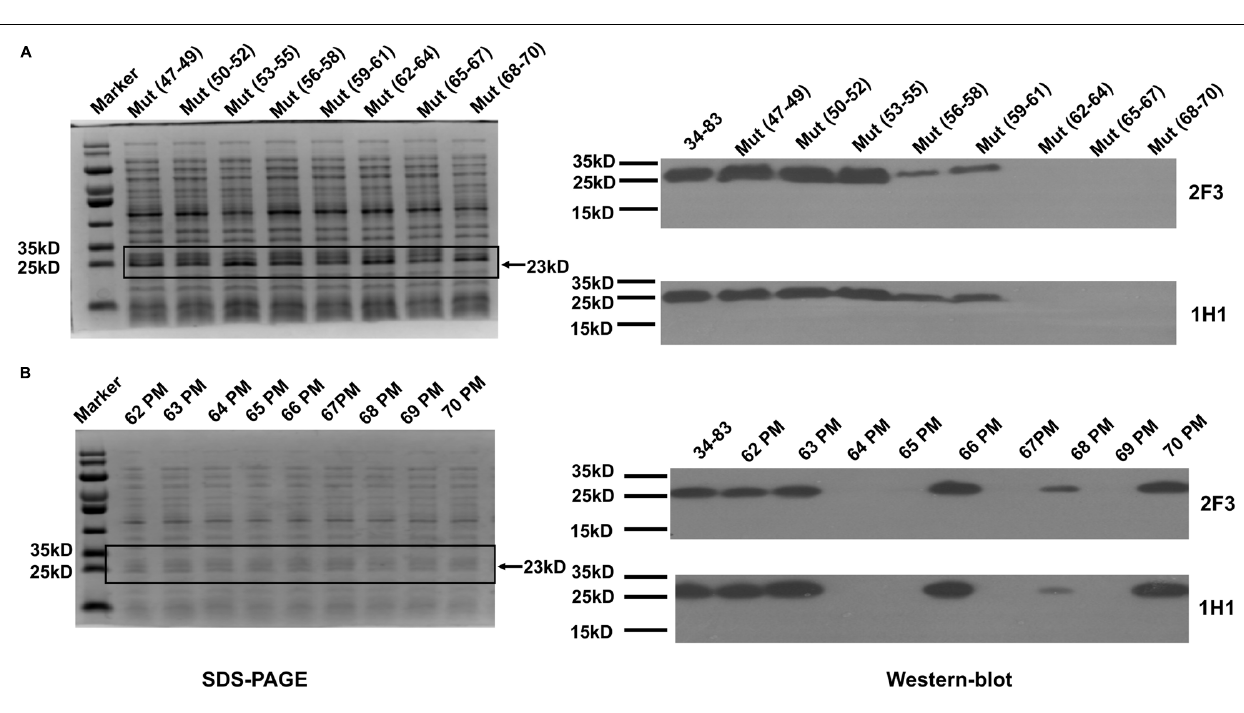
FIGURE 5 | Identification of critical amino acid residues in YycG ex domain epitope. Specific recognition by YycG ex mAbs of TF 34 − 83 harboring alanine substitutions was assessed using Western blotting. Binding of YycG ex mAbs to TF 34 − 83 carrying (A) triple-alanine substitutions and (B) single-alanine